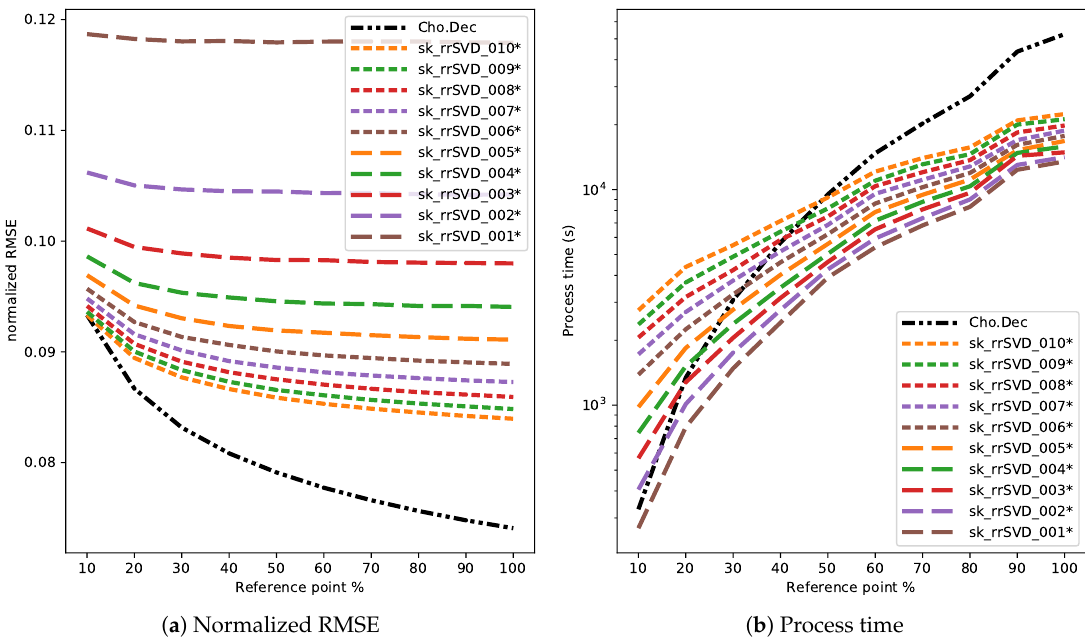
Figure 6. Normalized RMSE values ( a ) and process time in seconds taken to compute Equation (1) ( b ) as a function of reference point percentage for the Mnist dataset. Variants of sk_rrSVD_XX that differ statistically from Cholesky decomposition are marked with